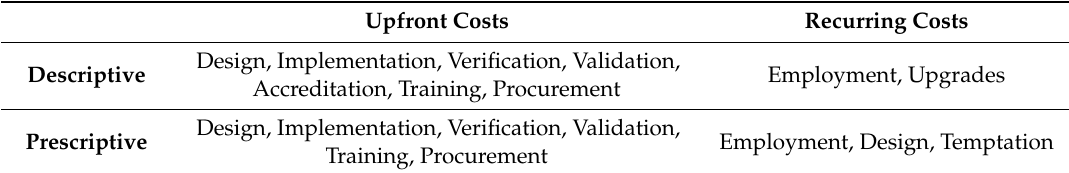
Table 1. Cost description for prescriptive and descriptive models.